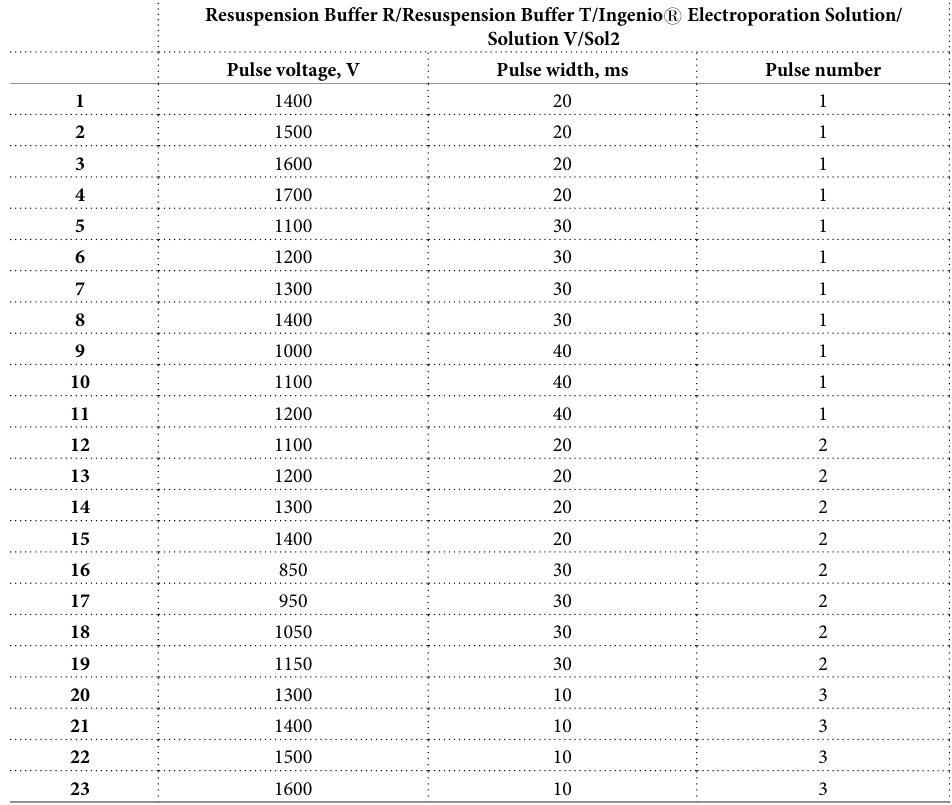
Table 2. CRISPR/Cas RNP delivery to target cells using Neon ™ Transfection